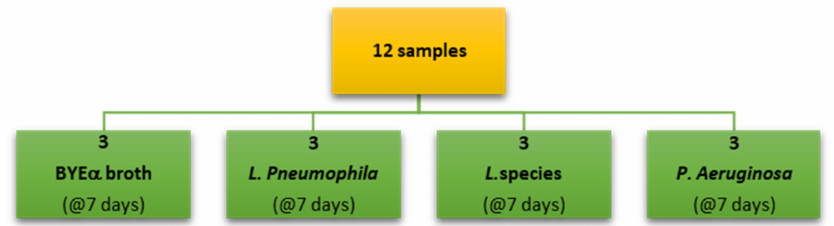
Figure 3. Experimental outline of GC-MS and fast GC-MS